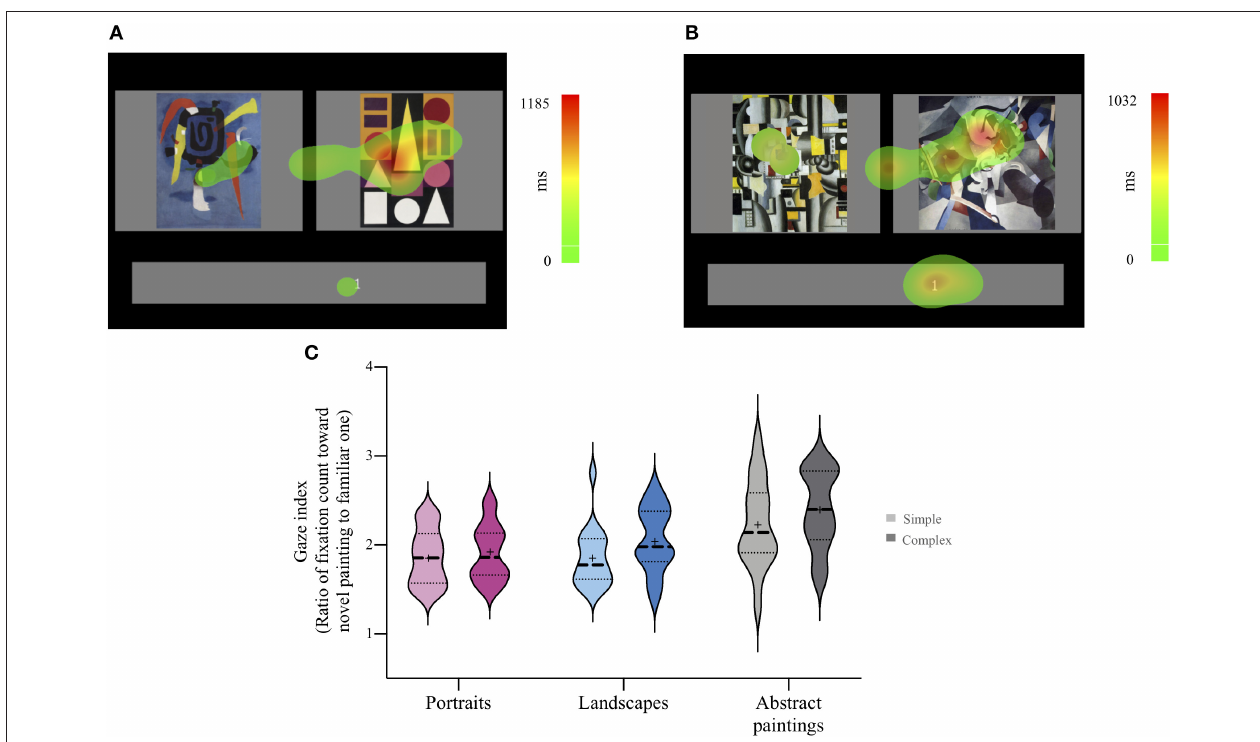
FIGURE 5 | Fixation heat map and the ratio of fixation count. Fixation heat map for simple (A) and complex abstract painting (B) trials. A 2-dimensional Gaussian filter was applied to each of the fixations, and the height of the Gaussian was weighted by the duration of the individual fixations. (C) The gaze index (i.e., the ratio of fixation count for novel paintings to that for familiar paintings) was calculated. Violin plots illustrate the distributions and the descriptive statistics of the individual gaze index for each of the six conditions. The cross hairs indicate the mean. The middle horizontal lines indicate the median, and the lower and upper lines indicate the first and third quartiles. The larger a gaze index is than 1, the more frequently a participant had fixated on novel rather than repeated, familiar